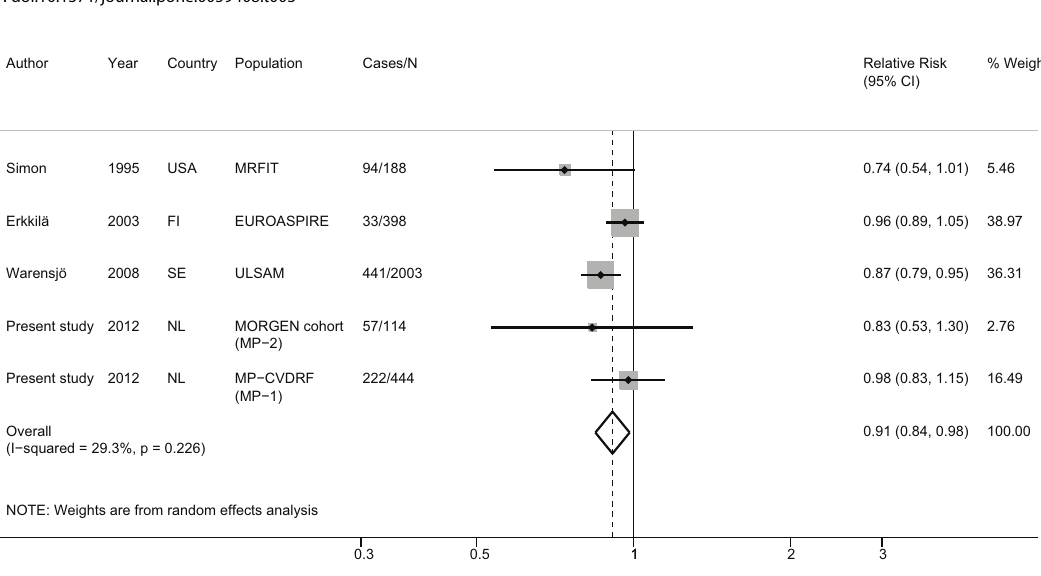
Figure 2. Pooled relative risk of cholesterol ester linoleic acid and CHD risk.